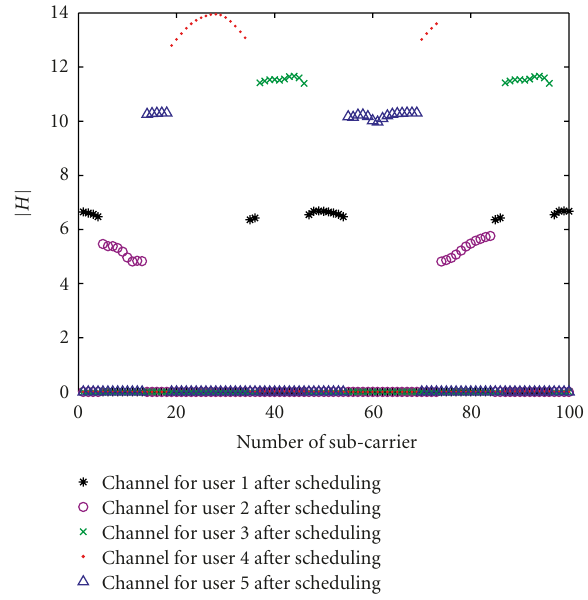
Figure 8: Channel allocation to the 5 users after scheduling in a typical urban